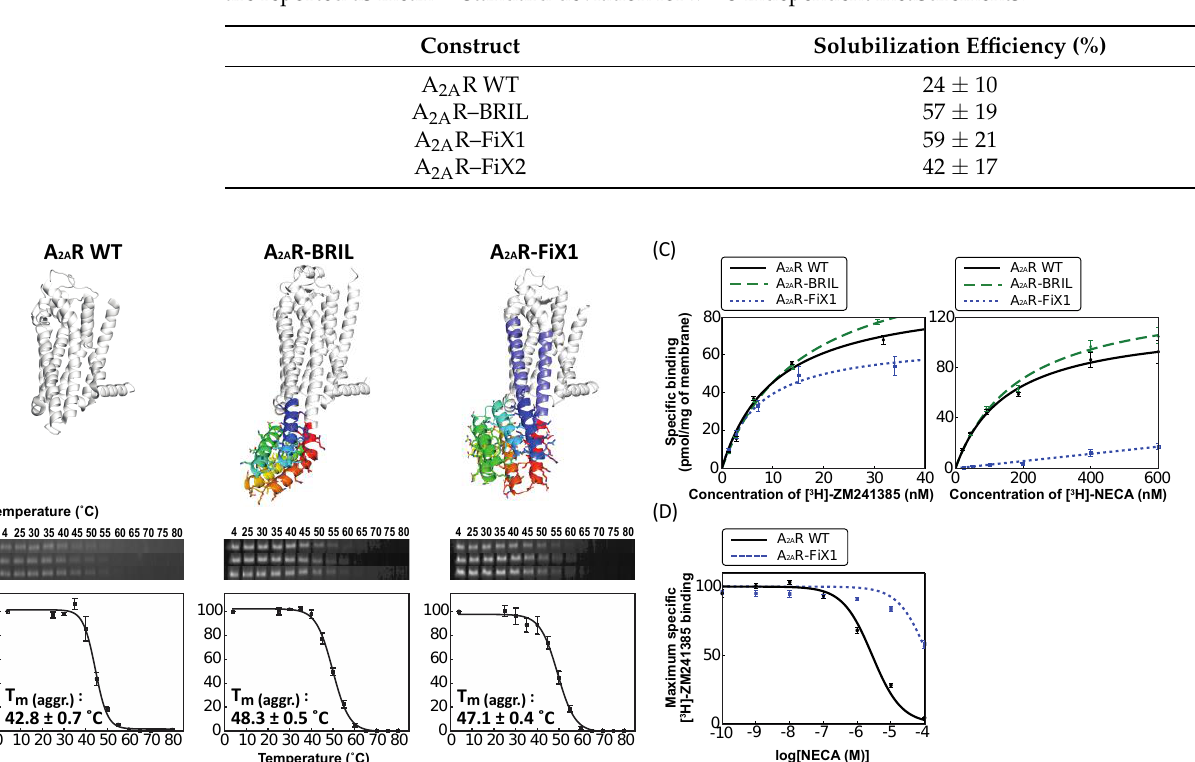
Table 1. Solubilization efficiencies of A 2A R fused with or without fusion partner proteins. Results are reported as mean ± standard deviation for n = 3 independent measurements.